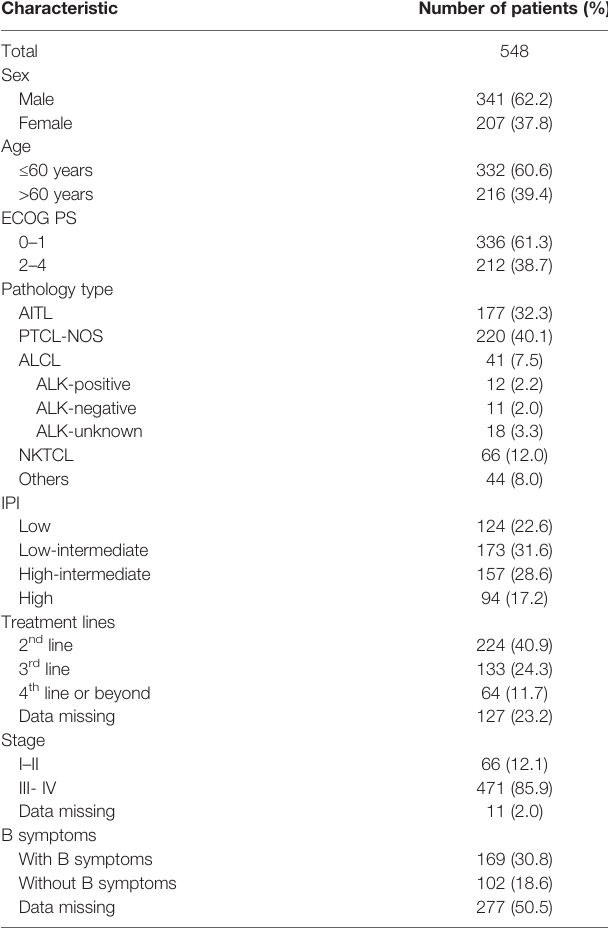
TABLE 1 | Baseline characteristics of 548 patients with relapsed or refractory PTCL.